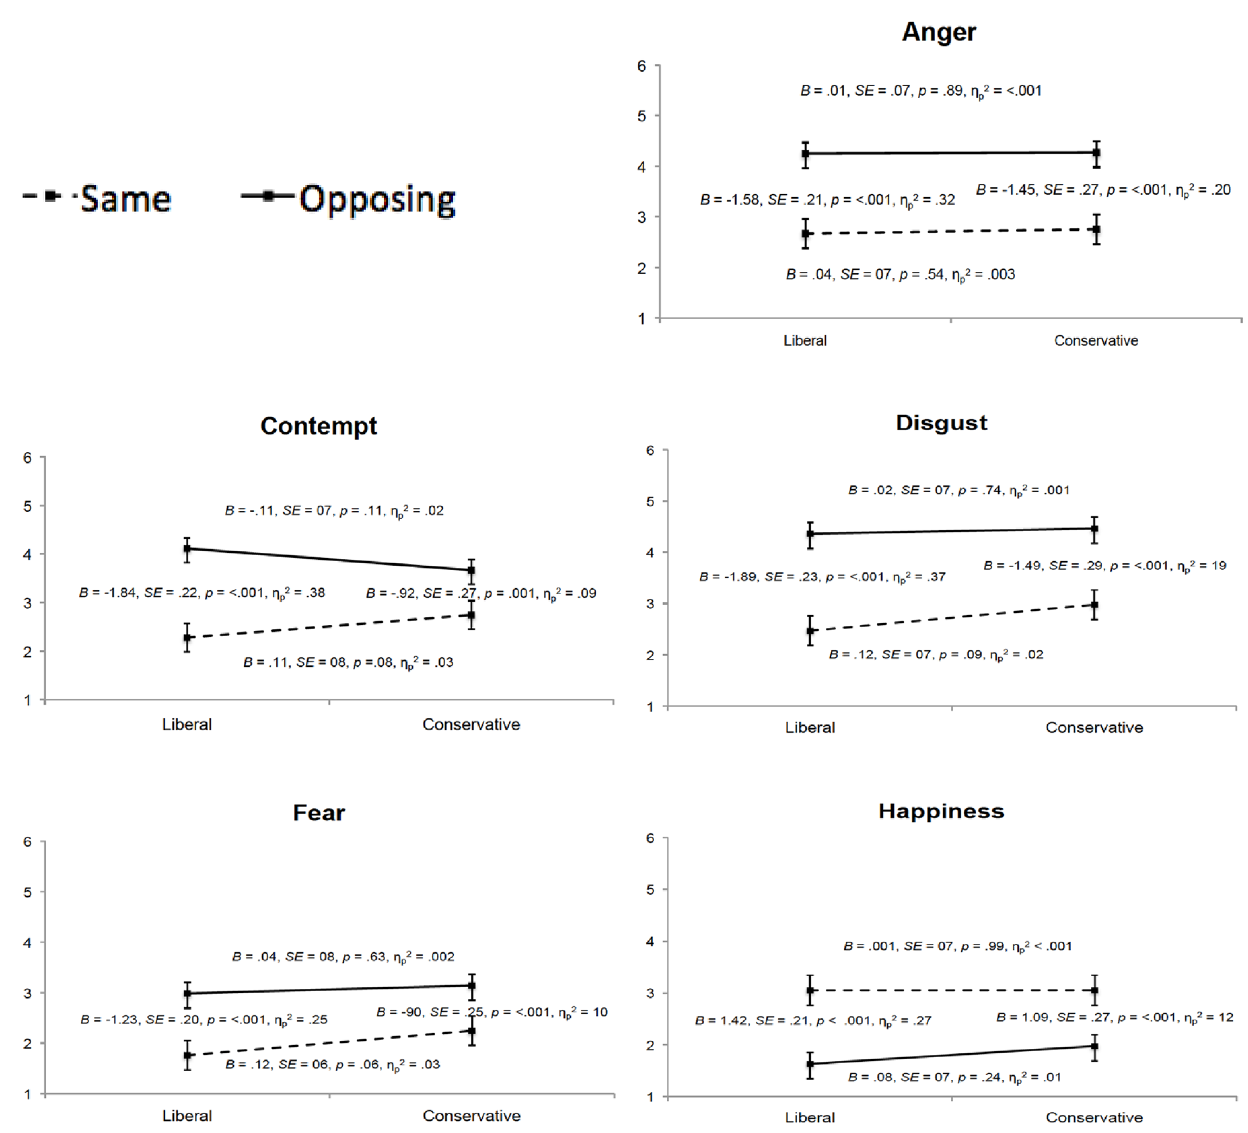
Figure 1. Graphs for Study 1 results. Note. The Liberal and Conservative labels on the horizontal axis represent continuous political